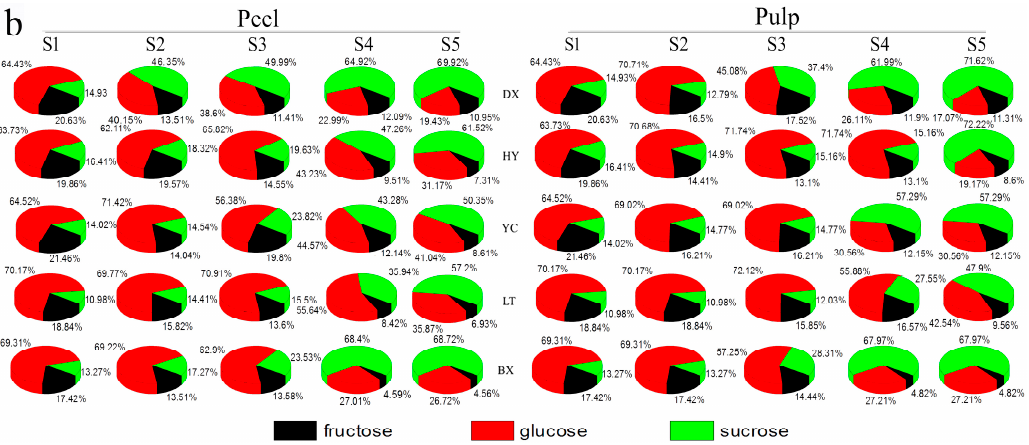
Figure 3. Sugar content (mg/g fresh weight, FW) and ratio in apricot fruit during development and ripening. ( a ) Changes in soluble sugar content; ( b ) The ratio of individual sugar content to total sugar content. Two capital letters in the middle are the cultivars shown in Table 1. All data are expressed as means ± standard error of triplicate samples.